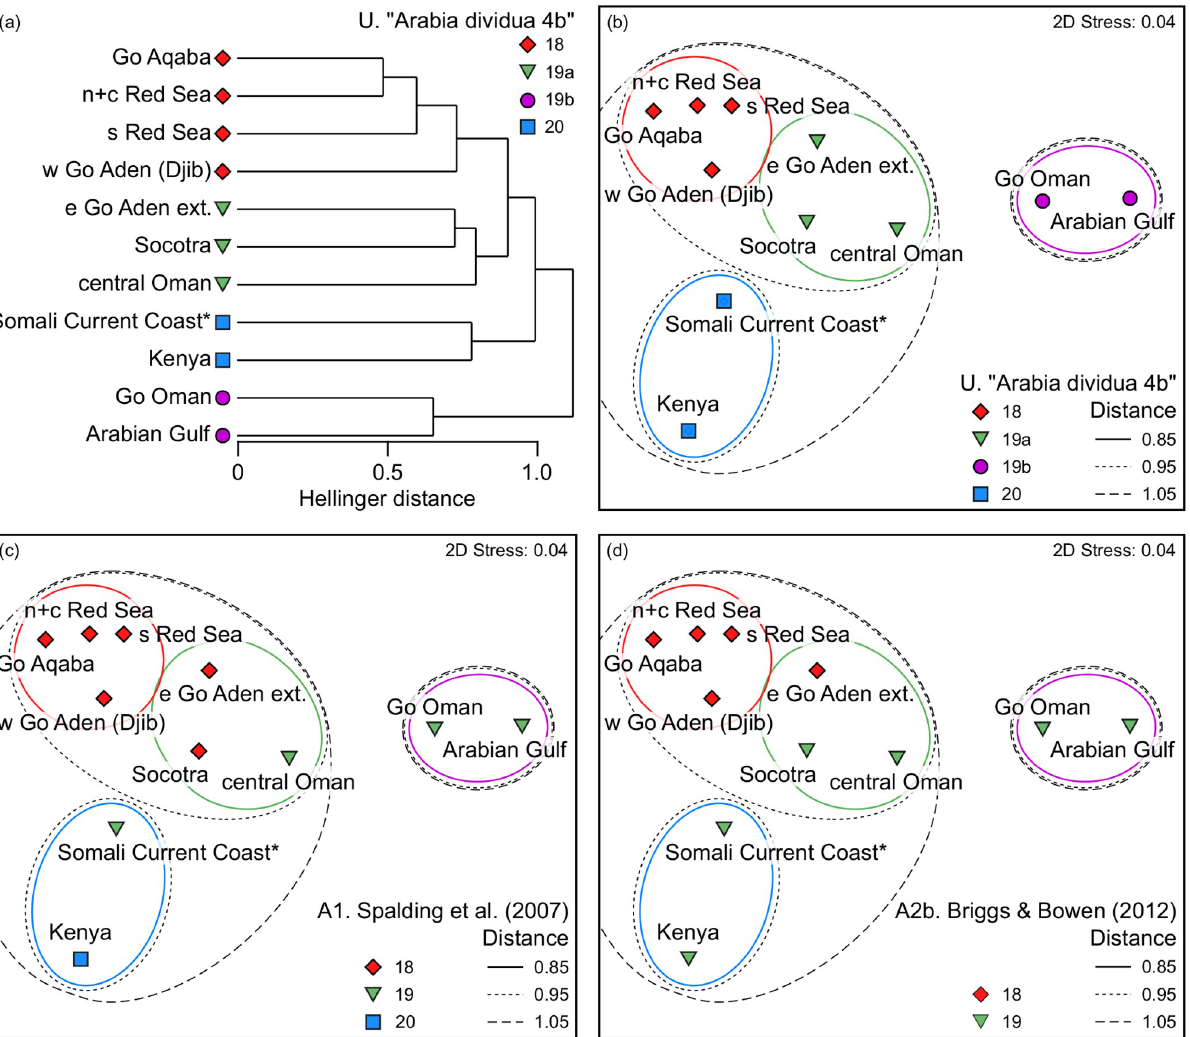
Fig 4. Resemblance pattern of 10 putative Arabian ecoregions and Kenya (8 key families, 404 species) based on Hellinger’s distance, represented as plots of the (a) dendrogram of the hierarchical agglomerative cluster analysis, and the (b) non-metric multidimensional scaling analysis (nMDS), both superposed with symbols representing the statistically (ANOSIM) most valid a priori -province-level Combination U (Table 1); compared with the same nMDS plot superposed with symbols representing the unsupported (ANOSIM) combinations (c) A1 following Spalding et al. (2007) and (d) A2b following Briggs and Bowen (2012) (province-level combinations A2a, A3b and A3a not shown because they are considered invalid according to ANOSIM; see S4 Fig).